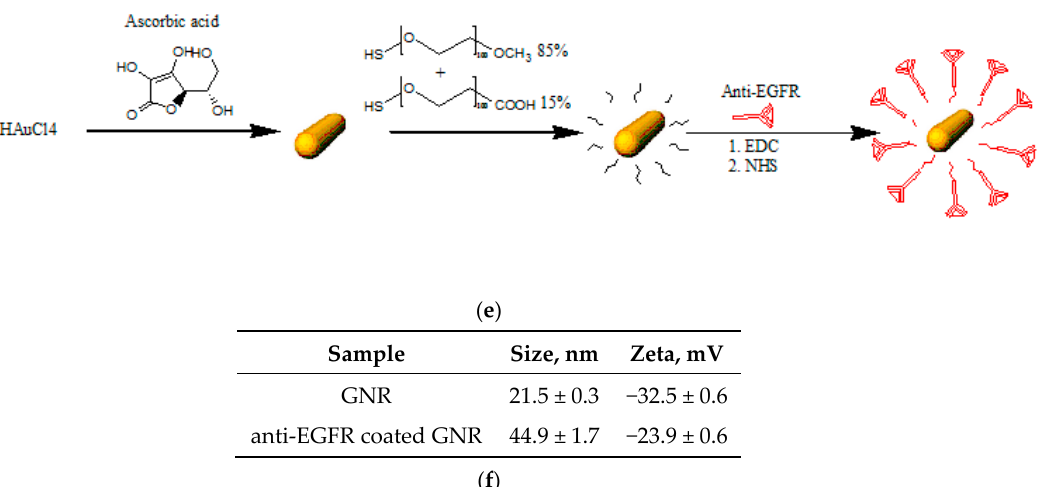
Figure 2. Characterization of GNRs. ( a ) Optical properties of the GNRs: ultraviolet-visible spectroscopy of bare GNRs and anti-EGFR coated GNRs. The resulting absorption peak was 670 nm. ( b ) Transmission electron microscopy image of the GNRs. Average dimensions were 25 × 11 ± 2.2 nm (n = 10). ( c ) Optical properties of the GNSs: ultraviolet-visible spectroscopy of anti-EGFR coated GNSs. The resulting absorption peak was 530 nm. ( d ) Transmission electron microscopy image of the GNRs. Average dimensions were 20 ± 4.3 nm (n = 8). ( e ) Schematic diagram of the GNRs synthesis process and their coating with m-PEG (85%) and COOH-PEG (15%), which is followed by a covalent conjugation to anti-EGFR. ( f ) Zeta potential and dynamic light scattering (DLS) size measurements (at 250 °C) of bare GNRs and anti-EGFR coated GNRs coated. The significant difference that was obtained (by zeta potential, DLS, and UV-vis spectroscopy) following coating, which demonstrates the efficiency of the chemical coating.